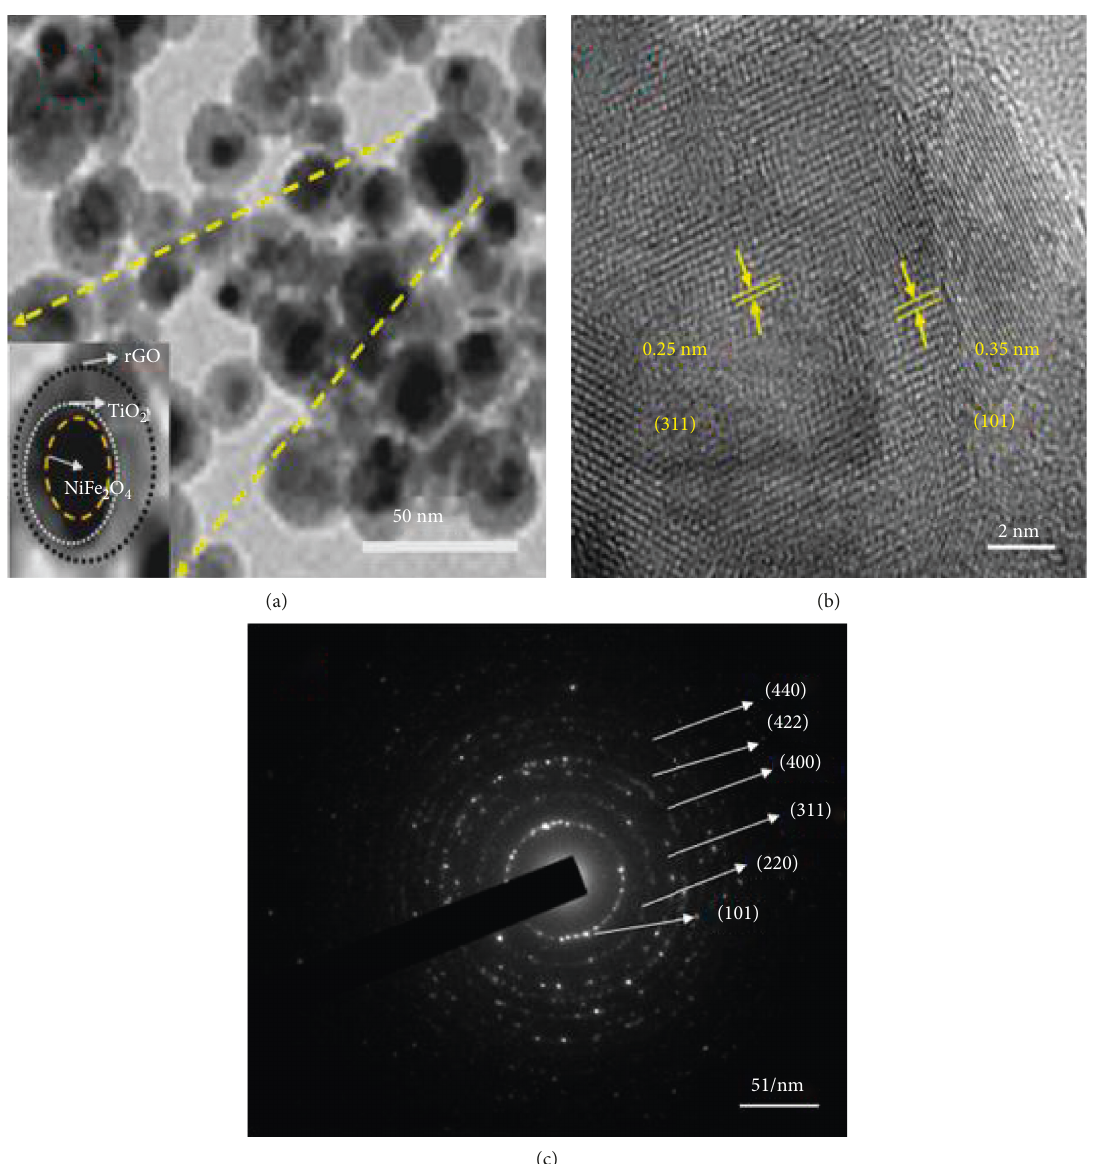
Figure 7: HRTEM image of NiFe 2 O 4 @TiO 2 @rGO core@shell